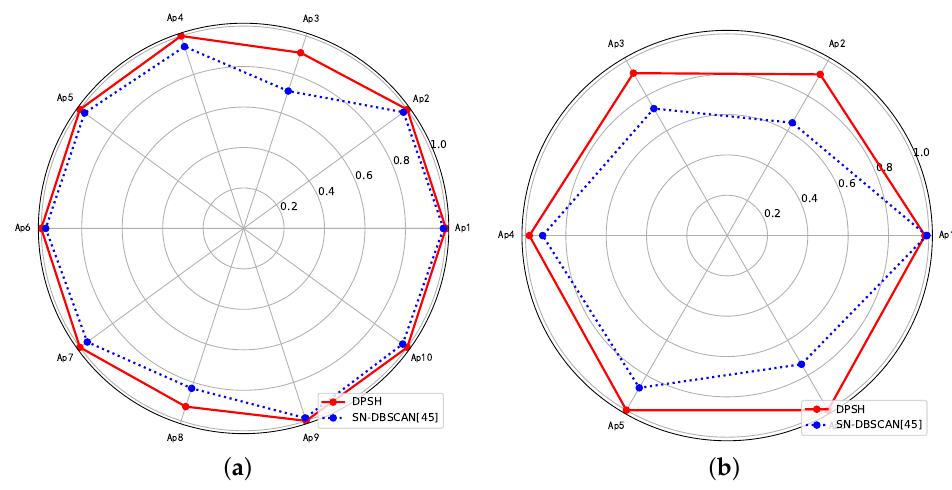
Figure 8. The performance on F 1 - score of DPSH and siamese neural network and DBSCAN clustering method (SN-DBSCAN) algorithm on two datasets. ( a ) The F 1 - score on REDD dataset. ( b ) The F 1 - score on PLAID dataset.